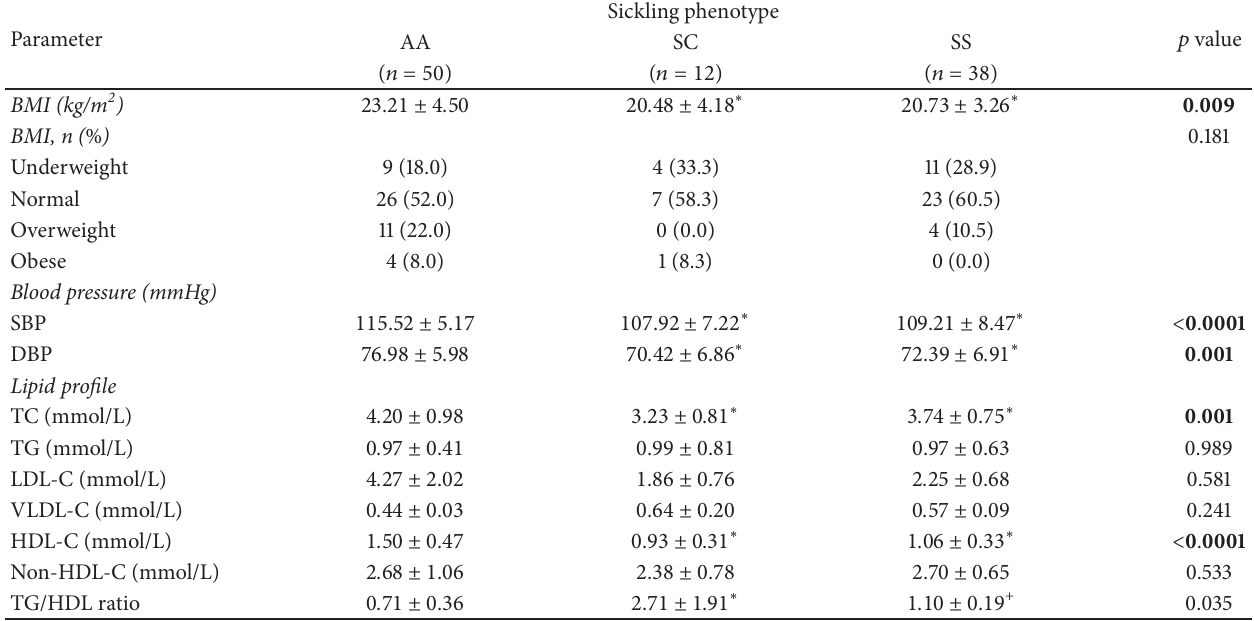
Table 2: BMI and lipid profiles in participants stratified by the type of haemoglobin variants.